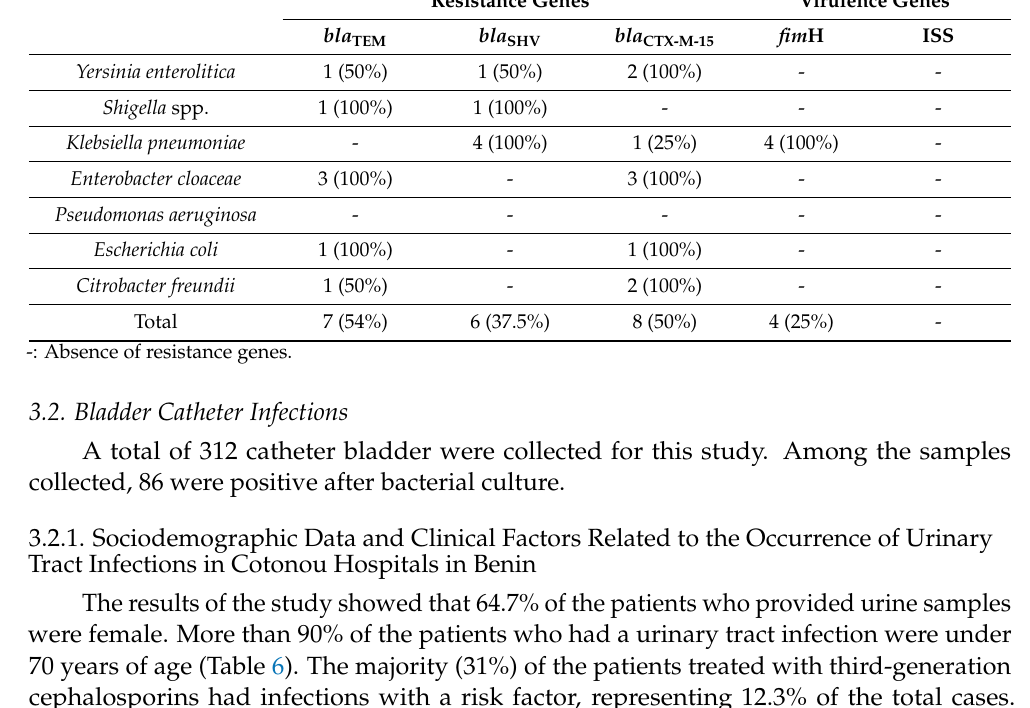
Table 5. Distribution of resistance and virulence genes in enterobacterial and non-enterobacterial strains. Resistance